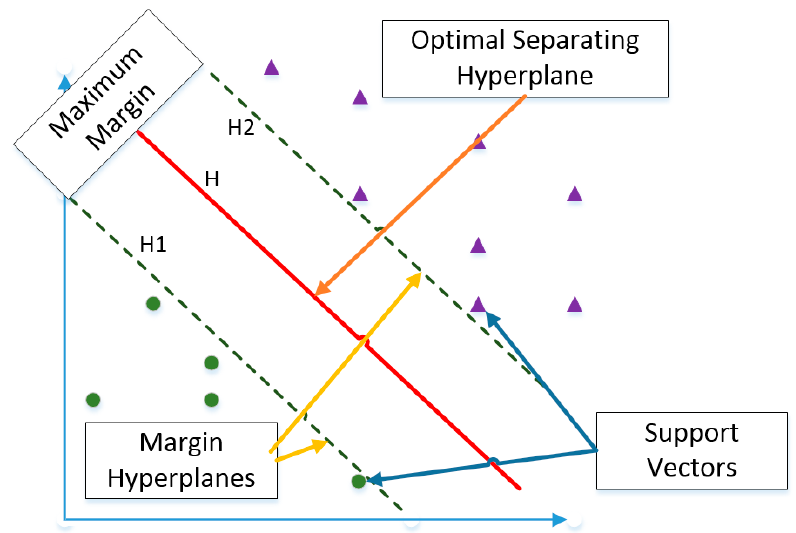
Figure 3. Support vector machine (SVM) operation with two dimensions [22].